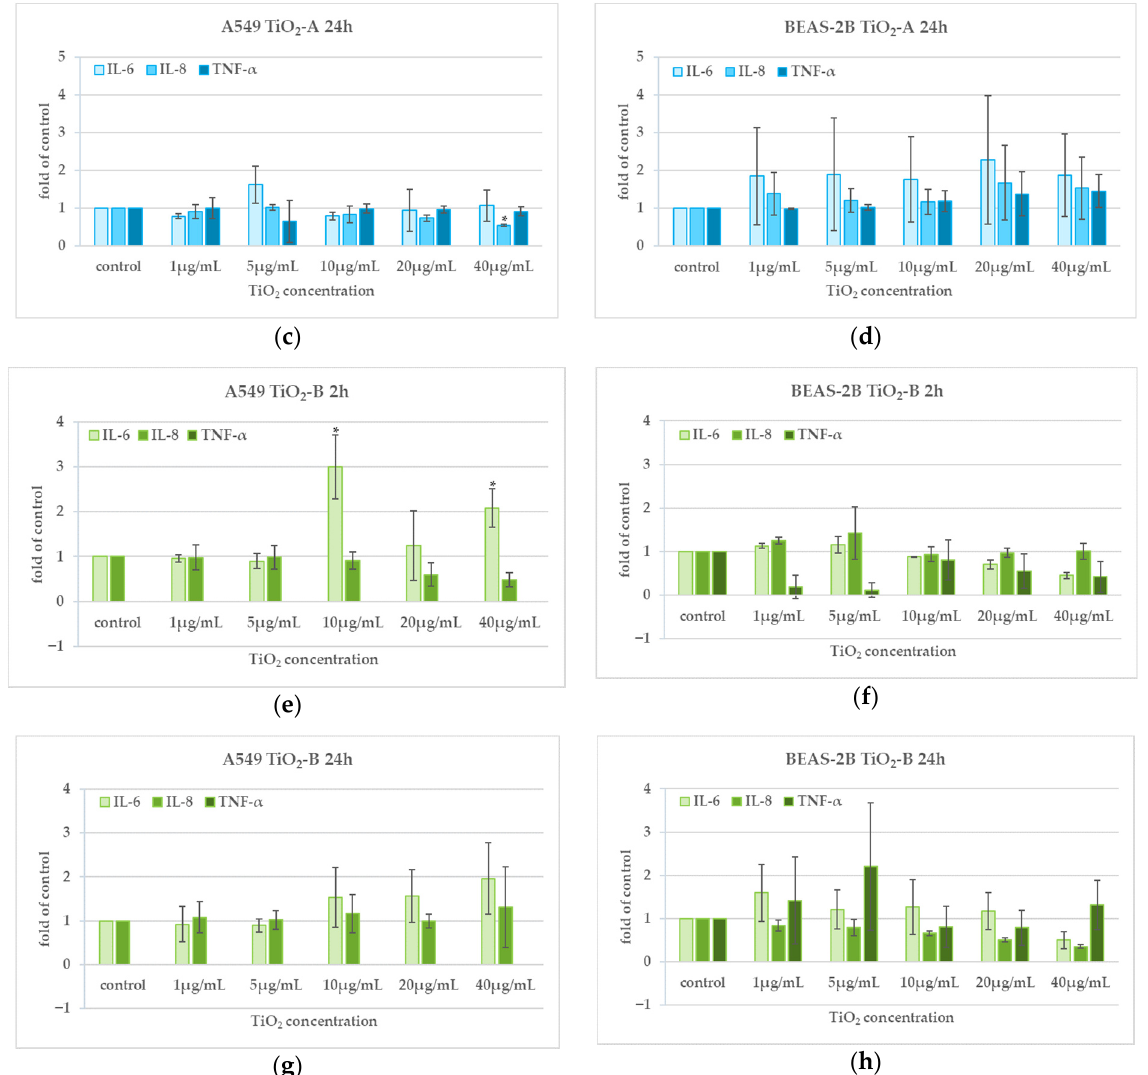
Figure 6. Cytokine release after 2 h ( a , b , e , f ) and 24 h ( c , d , g , h ) exposure to TiO 2 NPs in A549 and BEAS-2B cells. * p ≤ 0.05. Data relative to TiO 2 -A are previously published in [10] (Reproduced with permission from [10]. Copyright John Wiley & Sons, Ltd., 2014).